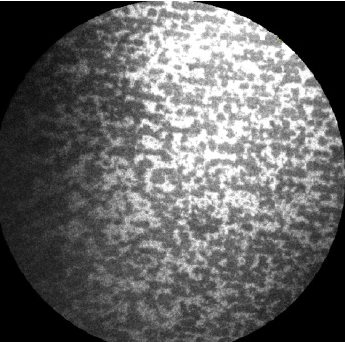
Figure 4. Si 2p oxide X-ray photoelectron emission microscopy (XPEEM) image taken at photon energy of 133 eV and electron energy of 26 eV with 40- µ m field-of-view for the buffer layer sample with T Ar = 1150 ◦ C. The bright areas correspond to higher content of SiO x but even the dark areas of the image have some oxide